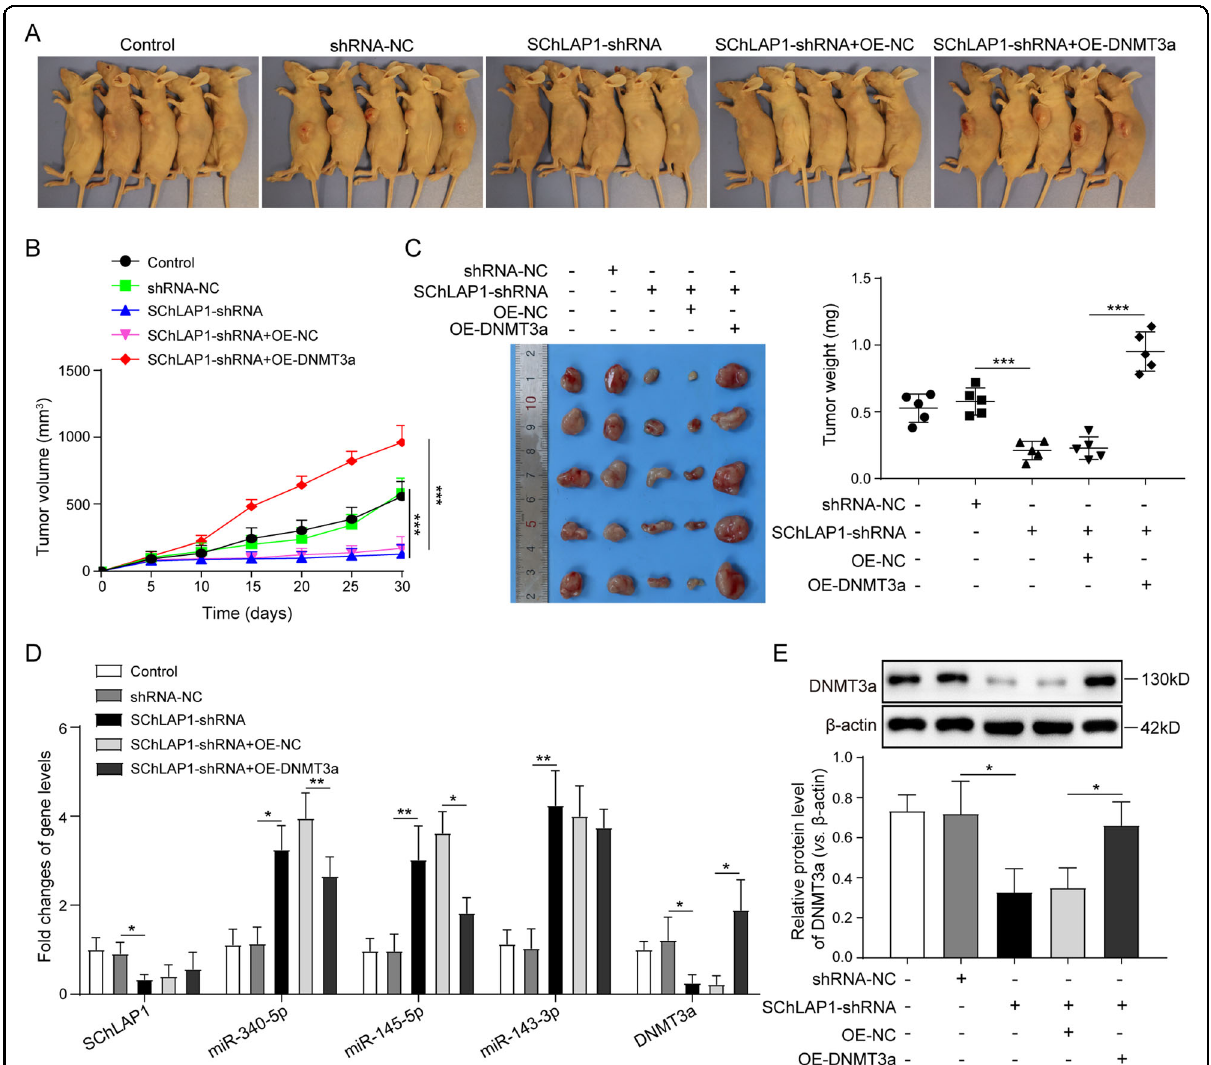
Fig. 7 SChLAP1/EZH2 promotes prostate cancer tumor development via the interaction of microRNA-DNMT3a signaling pathways in xenograft nude mice. A Subcutaneous xenograft nude mice models injected with DU145 cells with stably expressed SChLAP1-shRNA and/or DNMT3a. B The volume of tumor growth in the nude mice injected with DU145 cells with stably expressed SChLAP1-shRNA and/or DNMT3a during 30 days. C The weight of tumors isolated from the nude mice injected with DU145 cells with stably expressed SChLAP1-shRNA and/or DNMT3a. D QPCR analysis for the expression of SChLAP1, miR-340-5p, miR-143-3p, miR-145-5p, and DNMT3a mRNA in tumors isolated from the nude mice injected with DU145 cells with stably expressed SChLAP1-shRNA and/or DNMT3a. E Western blotting analysis for the DNMT3a protein level in tumors isolated from the nude mice injected with DU145 cells with stably expressed SChLAP1-shRNA and/or DNMT3a. The results are presented as the mean ± SD. * P < 0.05, ** P < 0.01, *** P < 0.001. SChLAP1 second chromosome locus associated with prostate-1, EZH2 Enhancer of Zeste Homolog 2, DNMT DNA